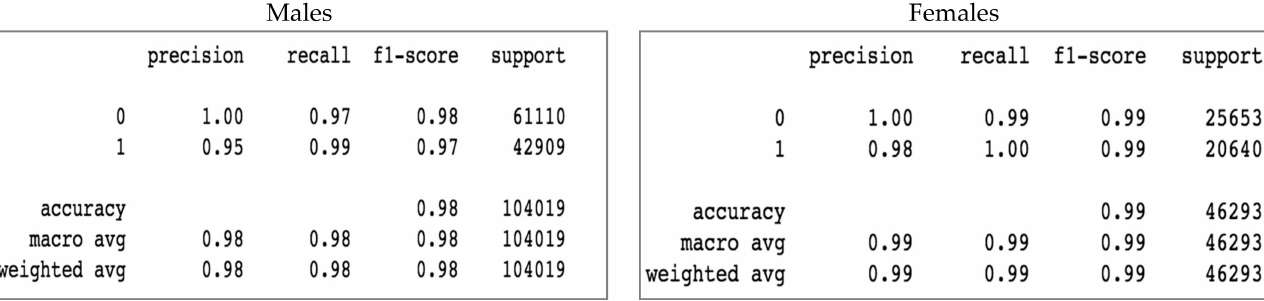
Figure 11. Classification report for VGG16’s experiment